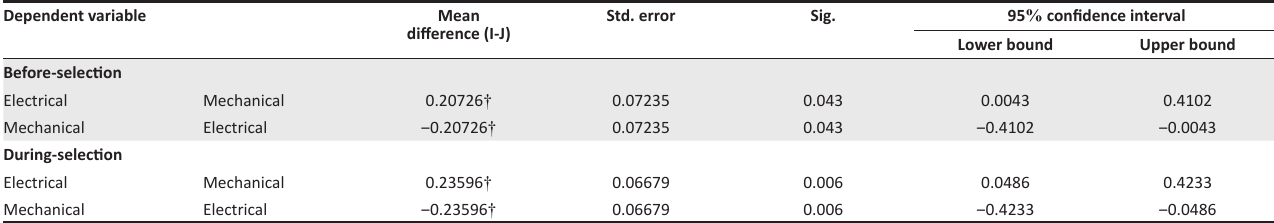
TABLE 5: Multi-comparison tests between engineering fields. Dependent